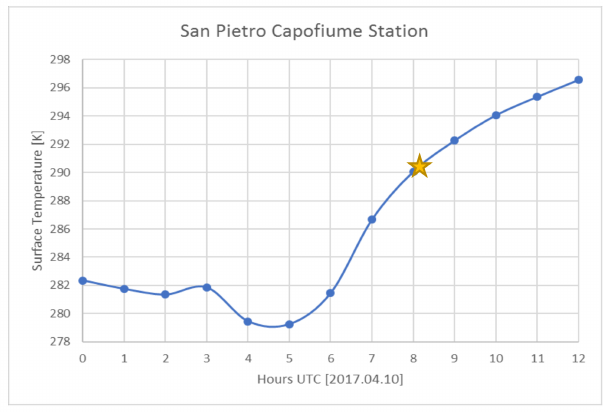
Figure 9. Surface temperature recorded by the station of San Pietro Capofiume (11.61 ◦ E; 44.65 ◦